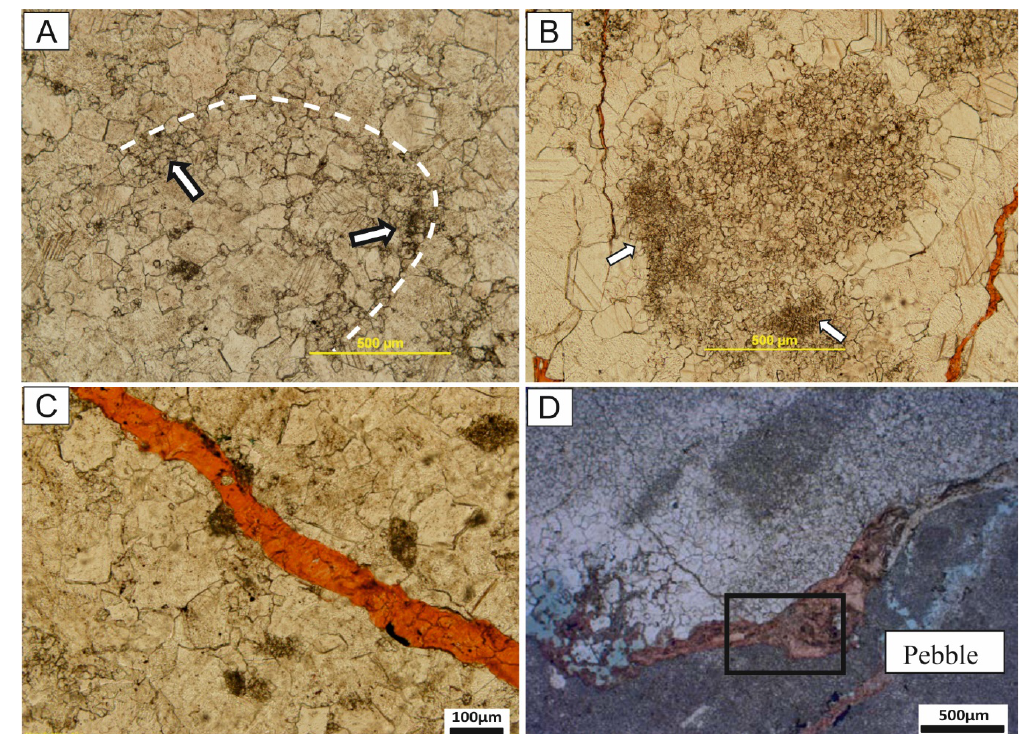
Figure 4. Optical photomicrographs (PPL) showing: ( A ) The fine dolomite crystals (arrows) in mosaic dolomite between pebbles are considered to be relics of fine-crystalline dolostone pebbles. The distribution of the fine dolomite crystals shows the rounded shape of pebble (dashed line). ( B ) The fine-crystalline dolostone pebble is partly replaced by the medium-crystalline dolomite (40 μm). Parts (arrows) of the pebble are not subjected to replacement. ( C ) Fracture cutting across the mosaic dolomite cement between pebbles was filled by the mosaic calcite cement (5 to 60 μm). The average width of this fracture is 70 μm. ( D ) Fracture-filling calcite along a pebble.